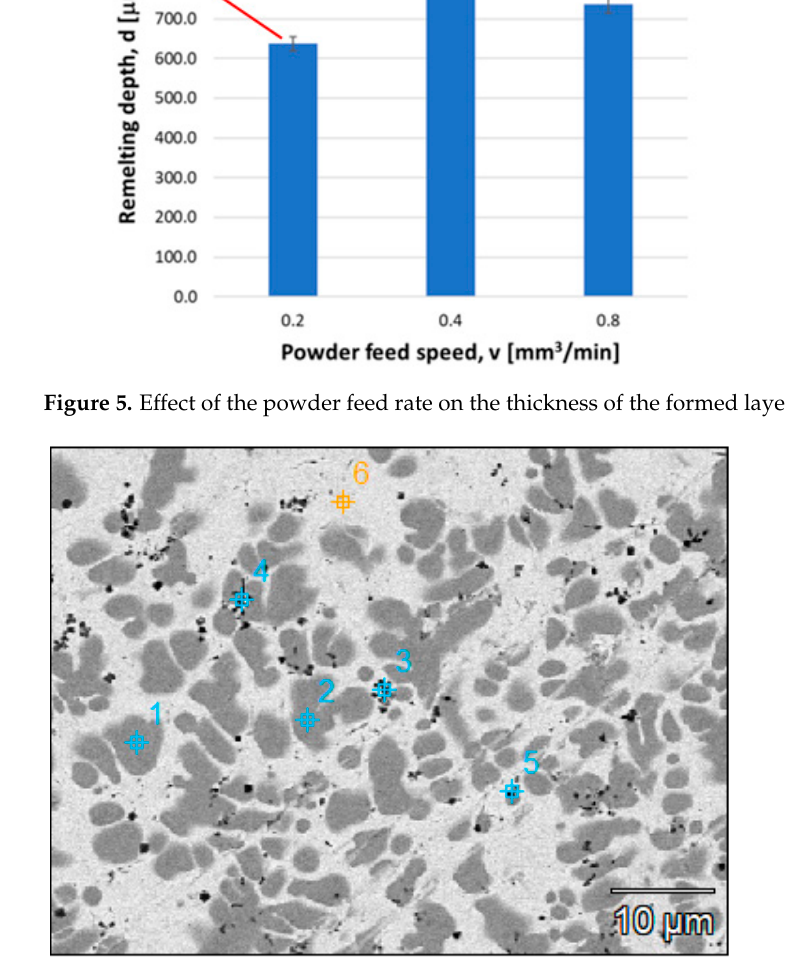
Figure 5. E ff ect of the powder feed rate on the thickness of the formed layer.